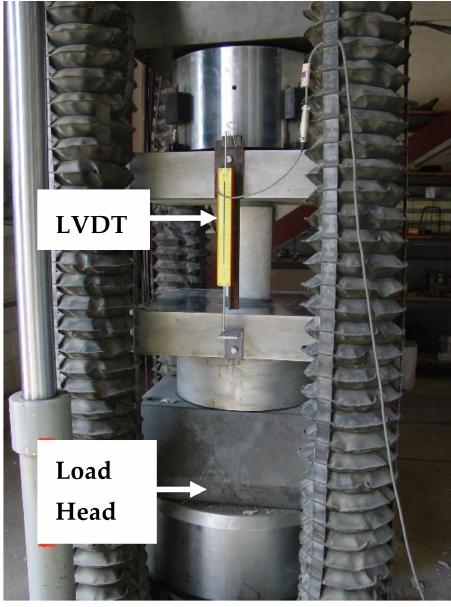
Figure 5. CFRP grid cylinder inside the loading frame with measuring instruments (load cell and displacement transducers (LVDTs)) [3].